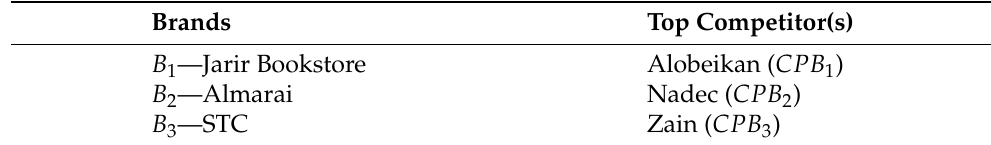
Table 4. Some main competitors of brands B 1 , B 2 , and B 3